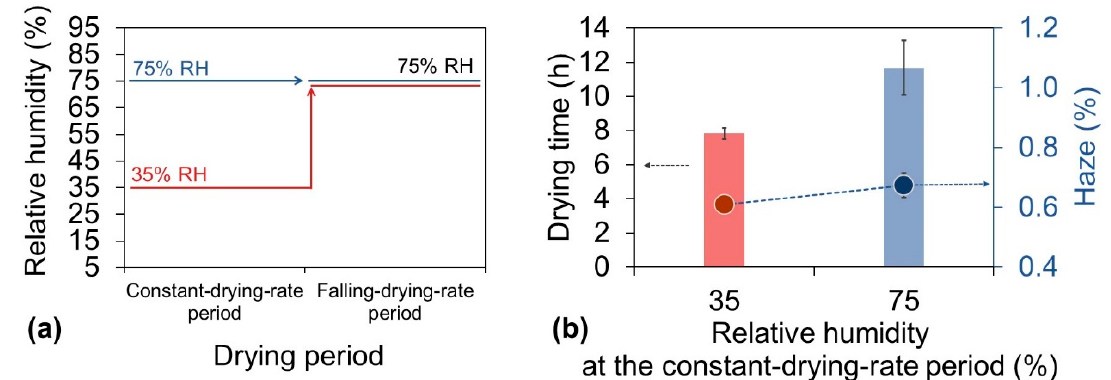
Figure 5. ( a ) Drying strategy for investigation of the relationship between the haze and RH during constant-drying-rate period. ( b ) Corresponding drying time (bar) and haze (dot) of cellulose nanopaper. During the drying process, the temperature was 85 °C for the entire period, and the RH was 35% or 75% during the constant-drying-rate period and 75% during the falling-drying-rate period.